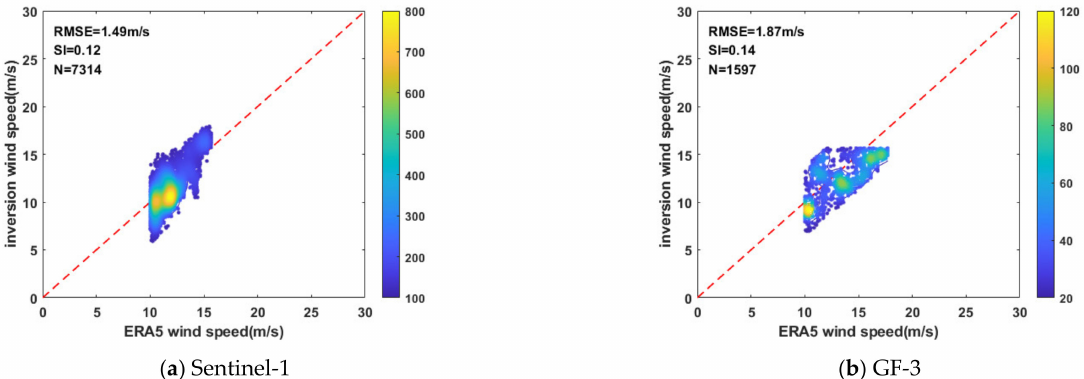
Figure 7. SAR data inversion results of Sentinel-1 and GF-3 when the wind speed is above 10